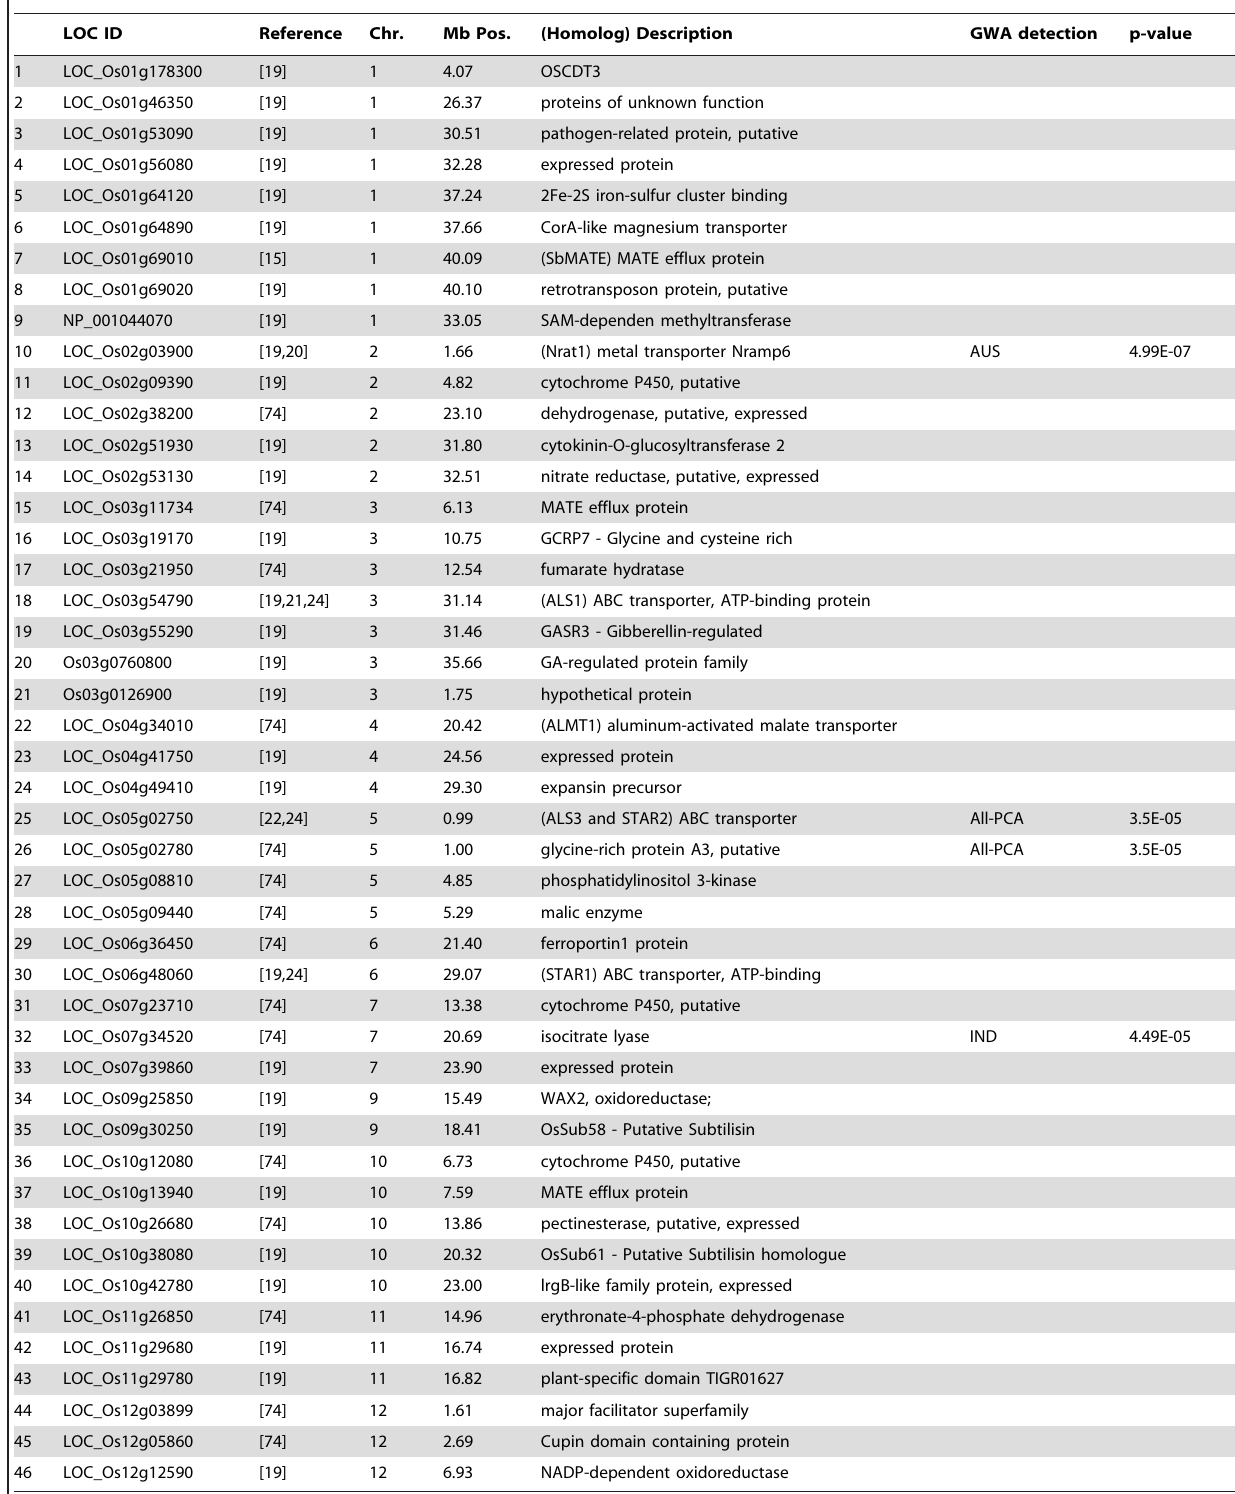
Table 2. List of 46 a priori Al tolerance candidate genes.